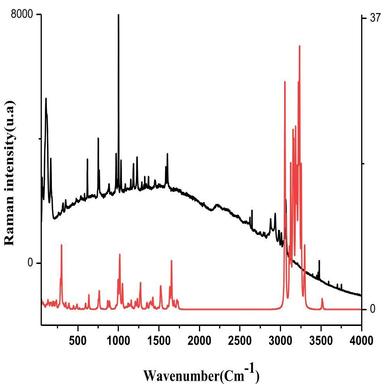
Room temperature experimental (black) and theoretical (red) Raman spectra of (C8H12N)42 recorded in the range 4000–10 cm-1.